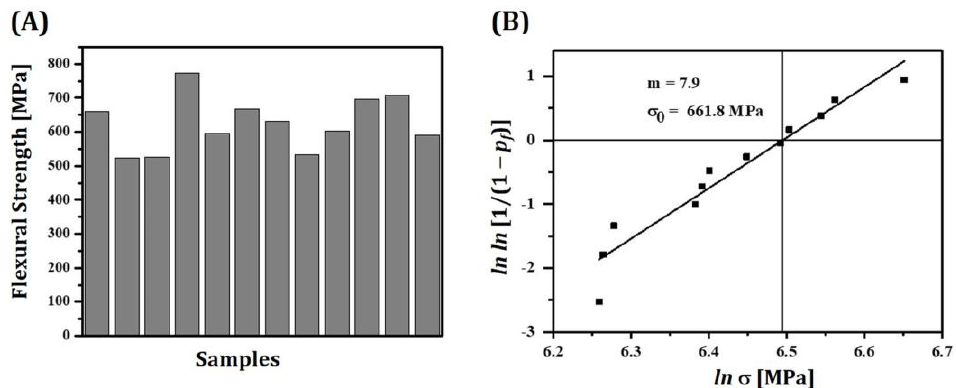
Figure 14. ( A ) Measured flexural strengths of 5Y-PSZ specimens and ( B ) Weibull plot of flexural strength.